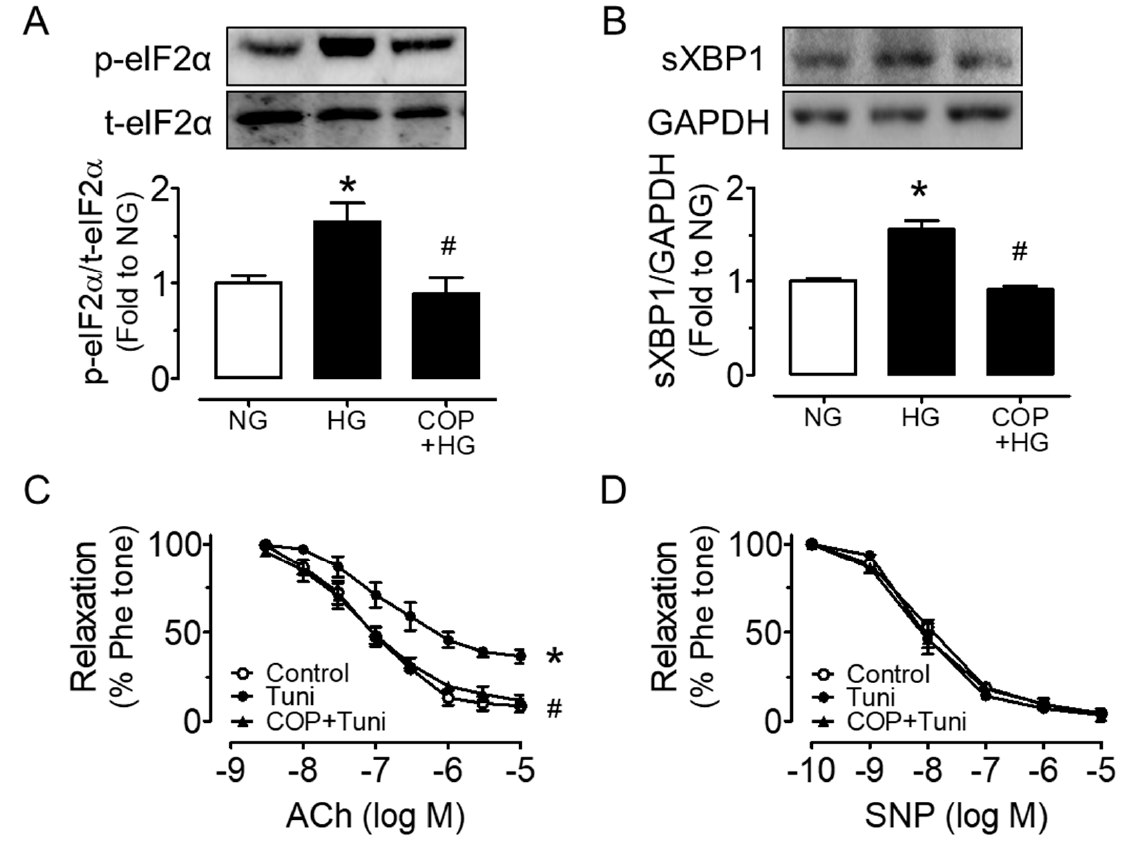
Figure 5. Coptisine (COP) inhibits ER stress. Representative blots and summarized data showing ( A ) the phosphorylation of eIF2 α at Ser52 (p-eIF2 α ; 36 kDa) compared to its total protein (t-eIF2 α ) and ( B ) spliced XBP1 (sXBP1; 54 kDa) compared to GAPDH (36 kDa) in mouse aortas treated with high glucose (HG, 30 mM) and COP (1 µ M) for 48 h. ( C ) ER stress inducer tunicamycin (tuni; 2 µ g/ml, 24 h) impaired the ACh-induced endothelium-dependent relaxations in aortas from C57BL/J mice ex vivo, which were improved by COP (1 µ M), with no effect on ( D ) SNP-induced relaxations. Results are the mean ± SEM of 3 experiments. * p < 0.05 vs. NG or Control; # p < 0.05 vs. HG or Tuni.